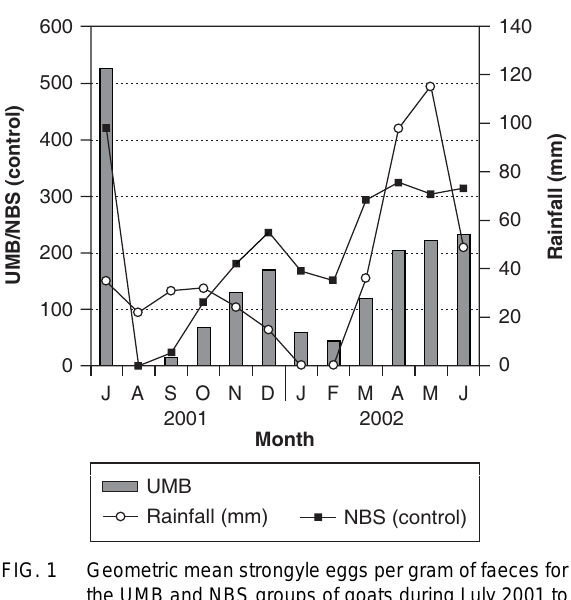
Geometric mean strongyle eggs per gram of faeces for the UMB and NBS groups of goats during July 2001 to June 2002 and total monthly rainfall